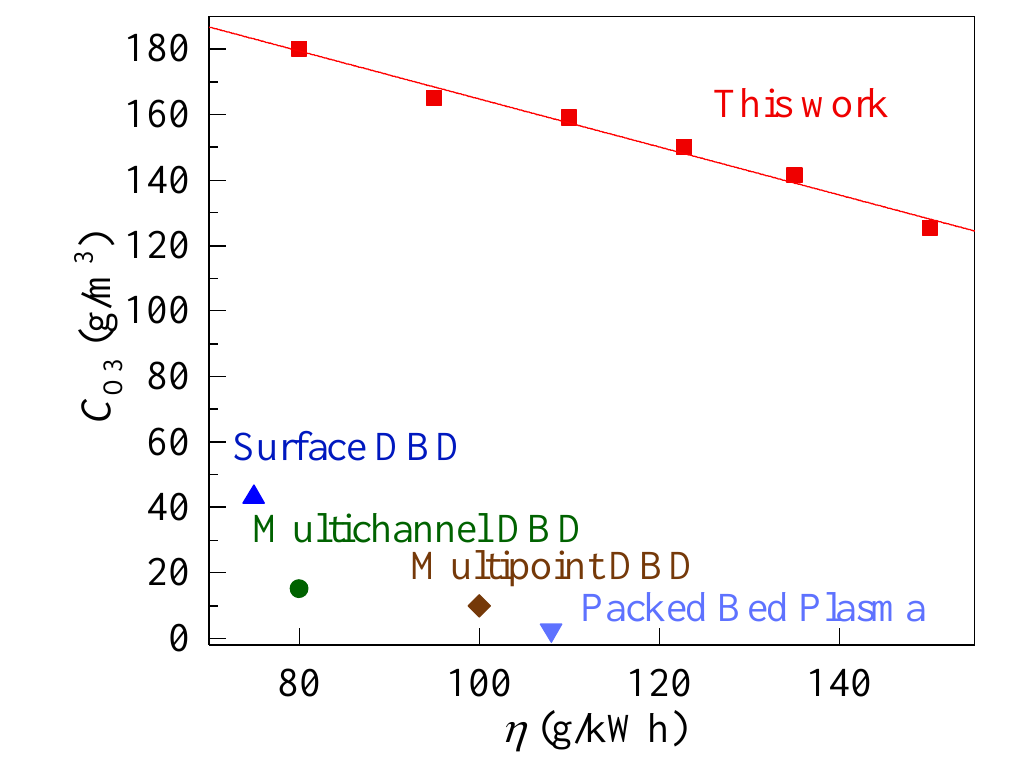
Figure 9. Comparison of η among various typical discharges for ozone synthesis.